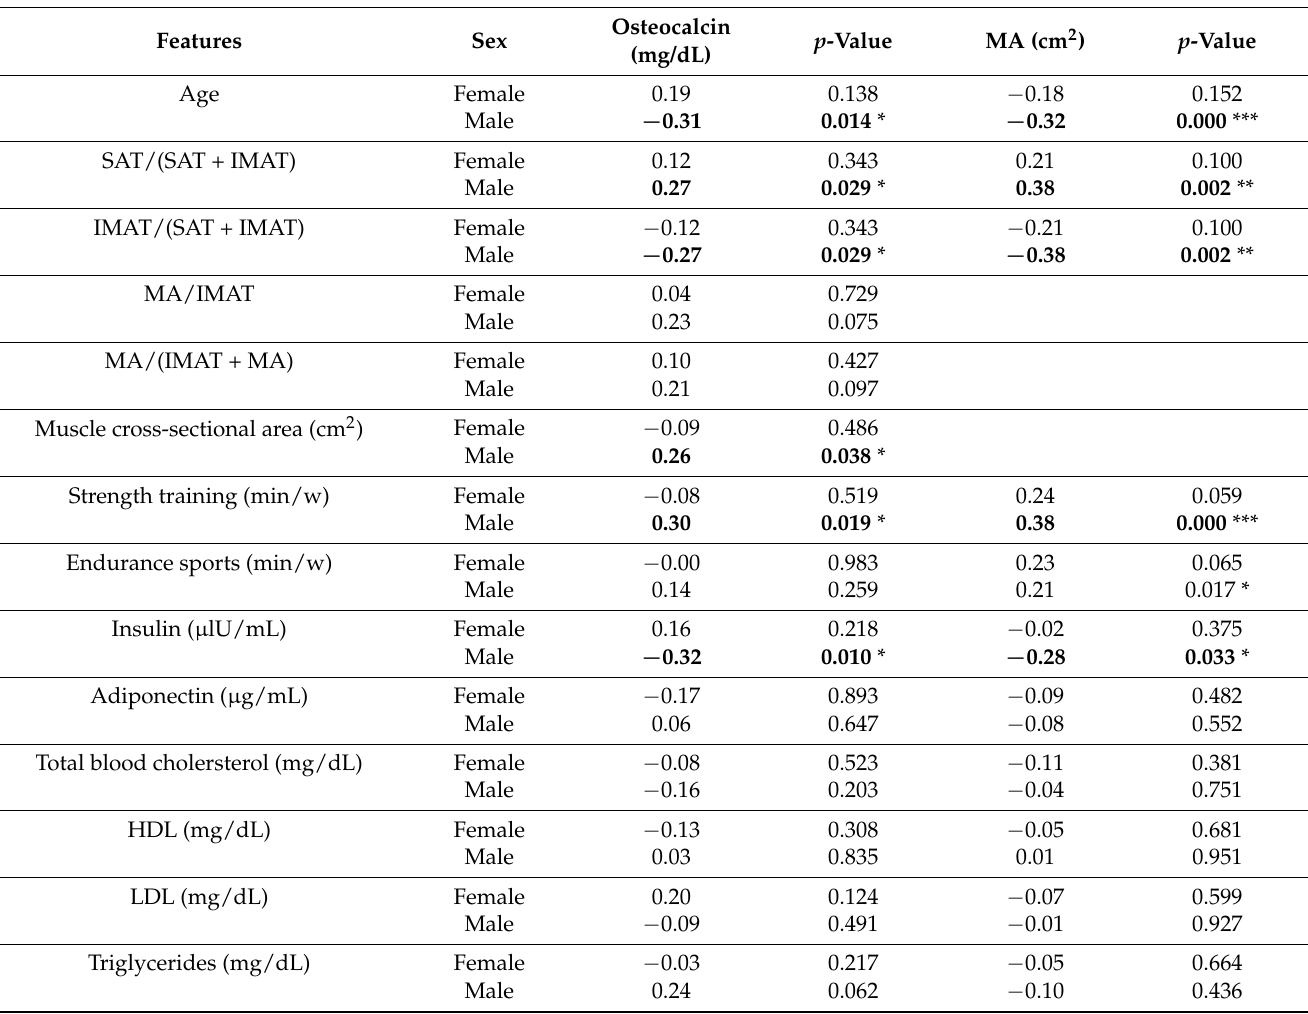
Table 2. Correlation between osteocalcin, insulin, age, tissue segmentation results, and type of sport in a sex-specific evaluation . Pearson correlation coefficients ( r -values) and associated p -values are